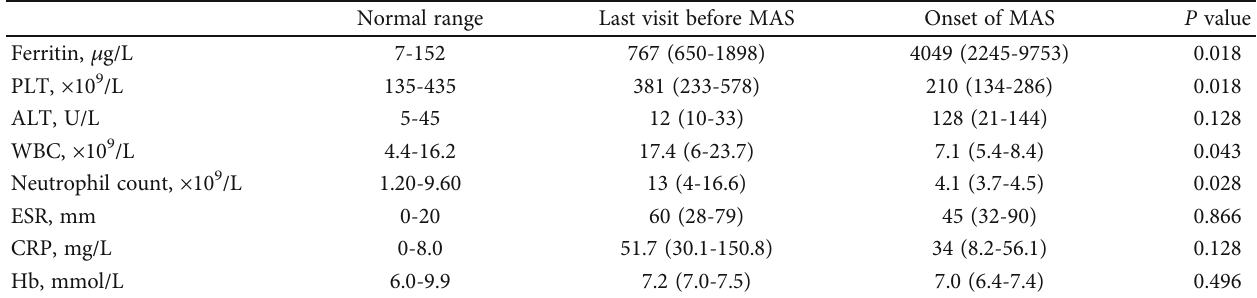
Table 5: Changes in laboratory values from last visit before onset of MAS to development of MAS according to 2016 MAS criteria ( n = 7 ). Normal range Last visit before MAS Onset of MAS P value Ferritin, μ